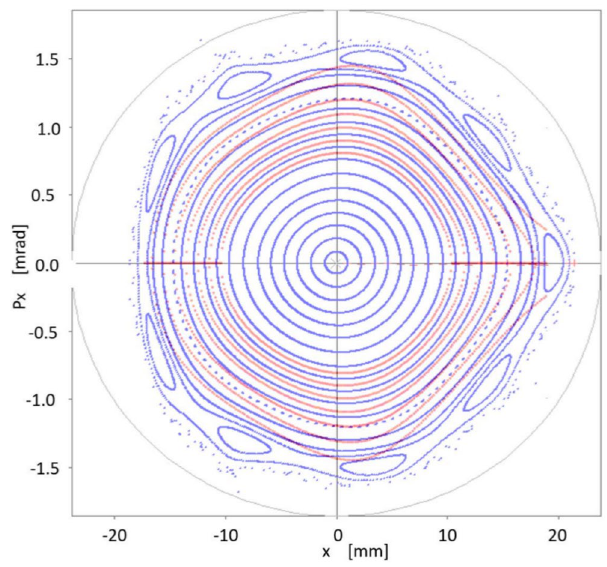
Figure 11. Structure of the phase space ( x , p x ) according to OPA particle tracking simulation (blue), showing good agreement with the dynamic aperture obtained with the quasi-invariant method (faint red superimposed, Fig. 10). Both calculations have been performed using the set of sextupoles { S 2 } for on-momentum particles ( δ = 0